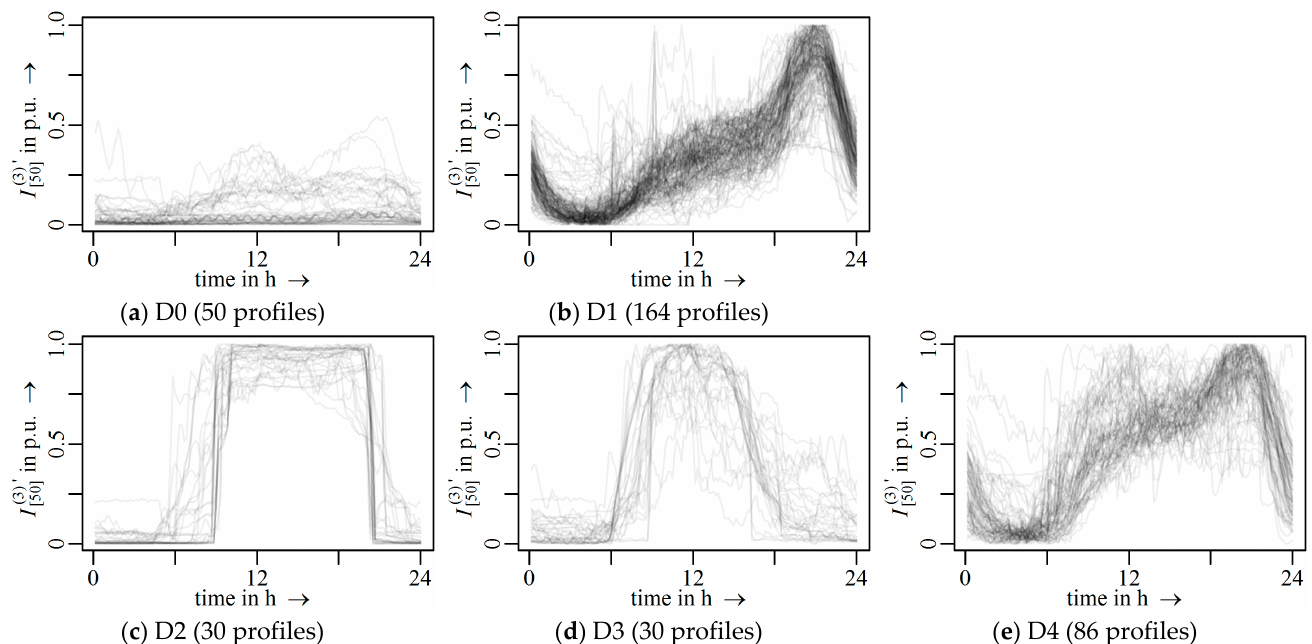
Figure 5. Classes of emission profiles for the 3rd harmonic current; min–max normalized 50th percentile time series for 40 measurements in LV grids within three groups: working days, Saturdays, and Sundays/holidays for all phases L1 to L3.